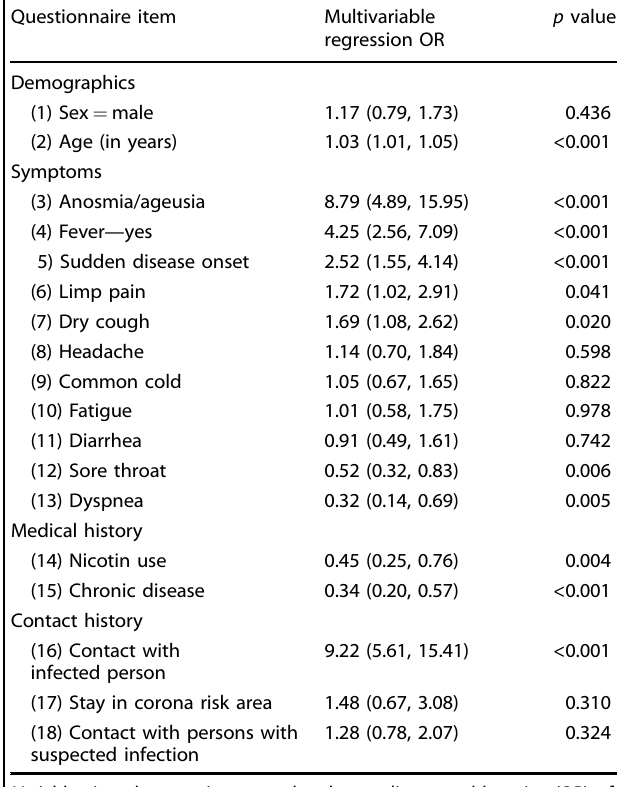
Table 1. Multivariable regression model of the questionnaire items. Questionnaire item